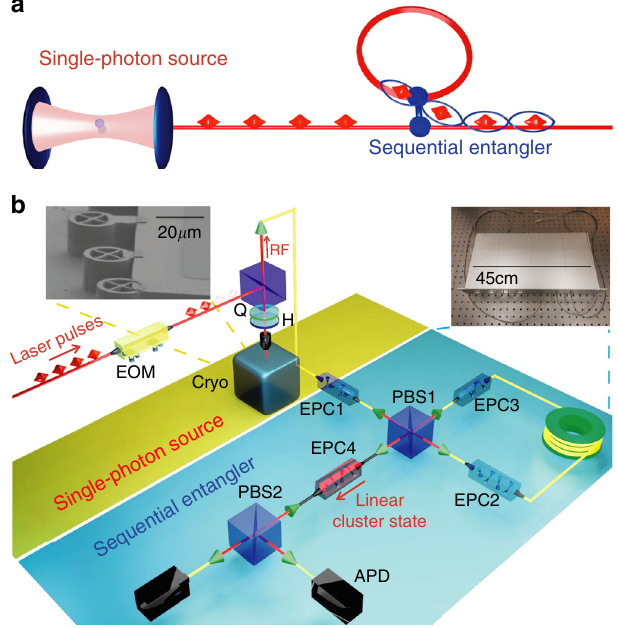
Fig. 1 A fi bered source of linear photonic cluster states. a Working principle of the source: single-photons generated in successive time bins, seperated by 74 ns, are sent into an apparatus where a delay-loop stores a photon until it meets with the next one at the entangling gate. b Top inserts: the physical implementation. A single InGaAs quantum dot photon source in an electrically-connected cavity, and an all- fi bered entangling optical circuit in a 19'' box. Bottom: Detailed experimental setup — EOM electro- optic modulator, Cryo cryostat, Q quarter-wave plate, H half-wave plate, RF resonance fl uorescence, EPC electrically-driven polarization controller, PBS polarizing beam-splitter, APD avalanche photon detectors; see text for additional